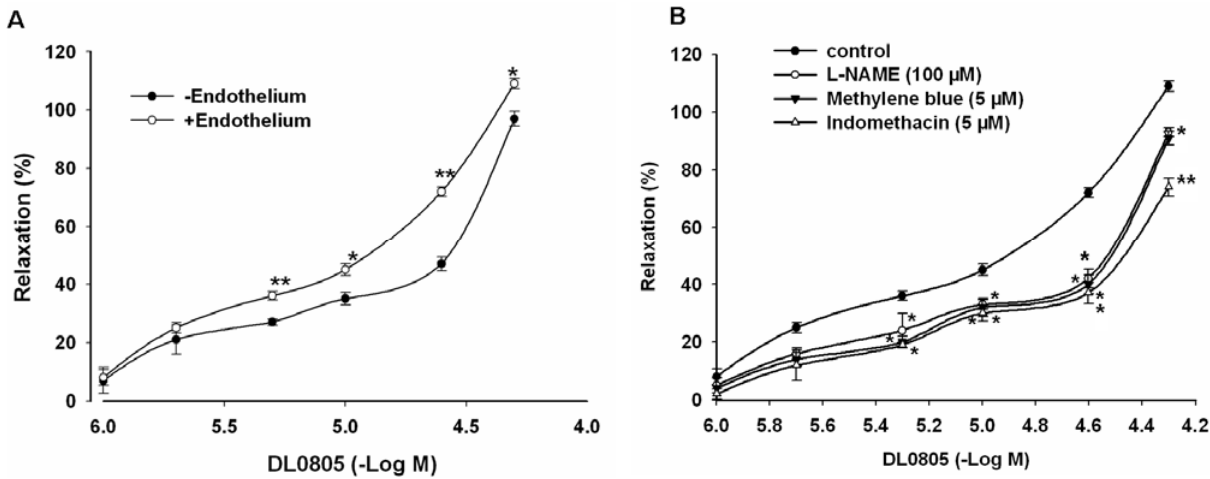
Figure 2. Vasorelaxant effects of DL0805 on the contraction induced by NE (1 μ M) in the aortic rings with (+Endo) or without (-Endo) endothelium ( A ) and effects of pre-incubation of L -NAME (100 μ M), methylene blue (5 μ M) and indomethacin (5 μ M) on DL0805 induced relaxation in endothelium-intact aorta ( B ). Results are presented as means ± S.E.M., n = 6. * P < 0.05, ** P < 0.01 compared with endothelium-intact aorta ( A ) or * P < 0.05, ** P < 0.01 compared with control ( B